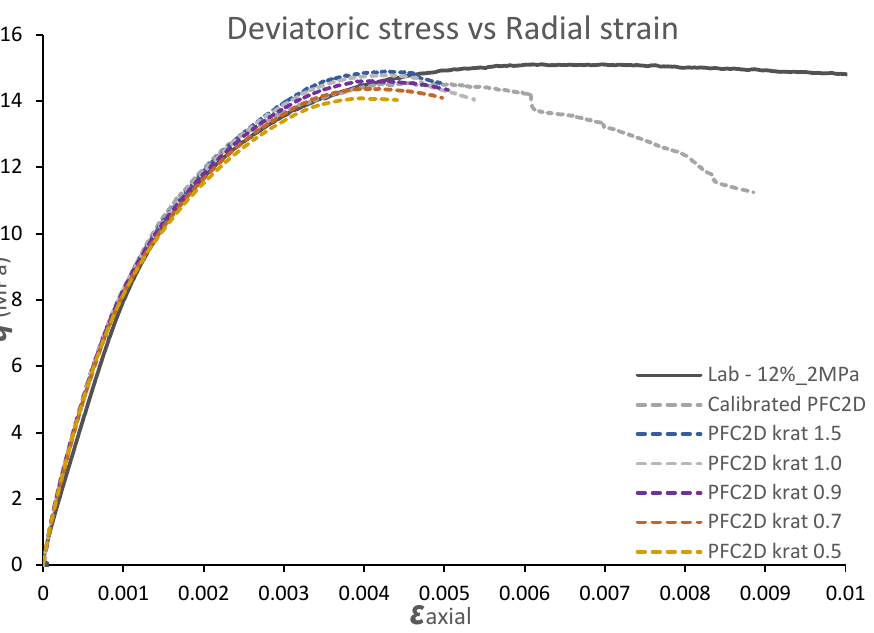
Figure 8. The effects of stiffness ratio on deviatoric stress .